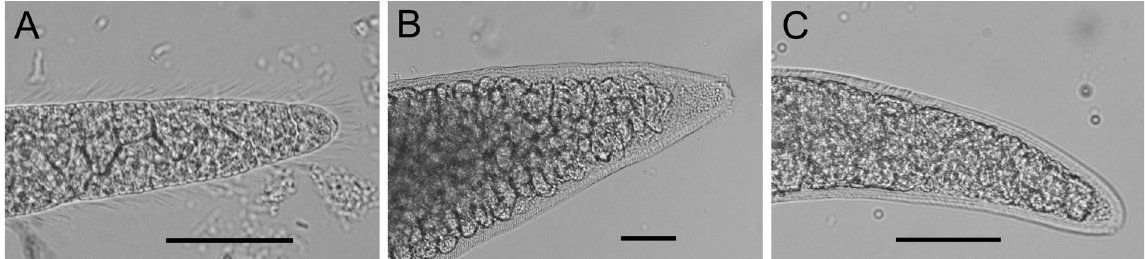
Figure 2. Morphology of Sarcocystis spp. isolated from beef. A, Sarcocystis cruzi ; B, Sarcocystis hirsuta ; C, Sarcocystis bovini . Bar: 50 m m. Table 4. Summary of polymorphic sites in the mtDNA cox1 gene (812 bp) of Sarcocystis fayeri sarcocysts isolated from horsemeat.